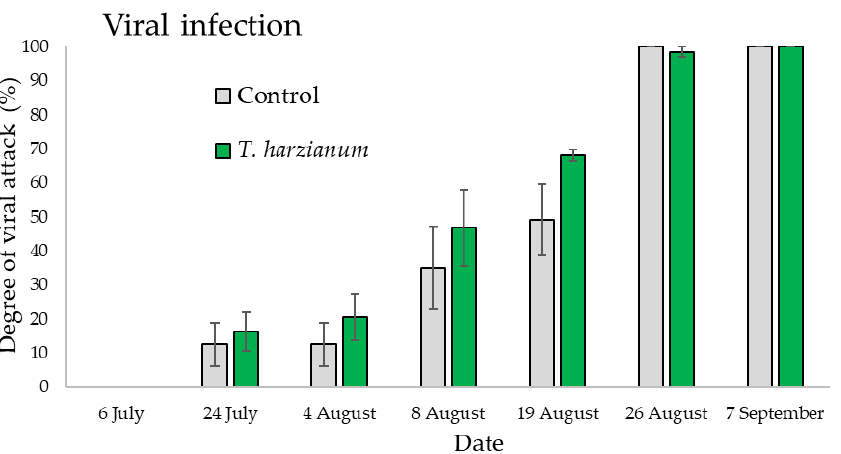
Figure 5. Mean degree of viral attack (± standard errors) in plots inoculated with T. harzianum T22 and control ones over time.